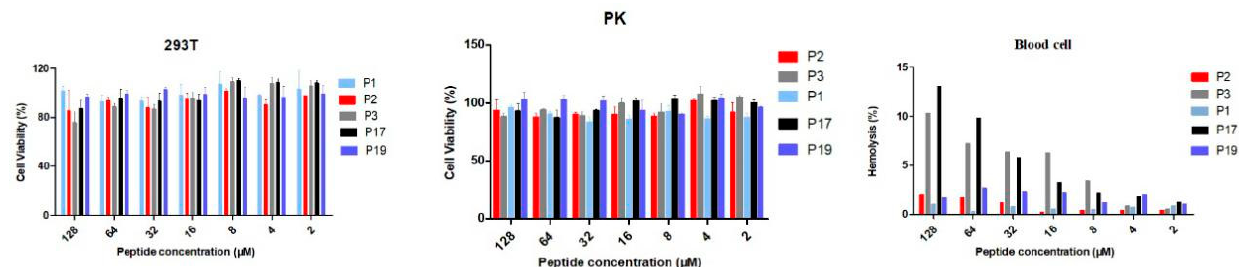
Figure 6. The biocompatible potential of the designed peptides. The cell lines were human embryonic kidney 293T, pig kidney PK and human red blood cells.